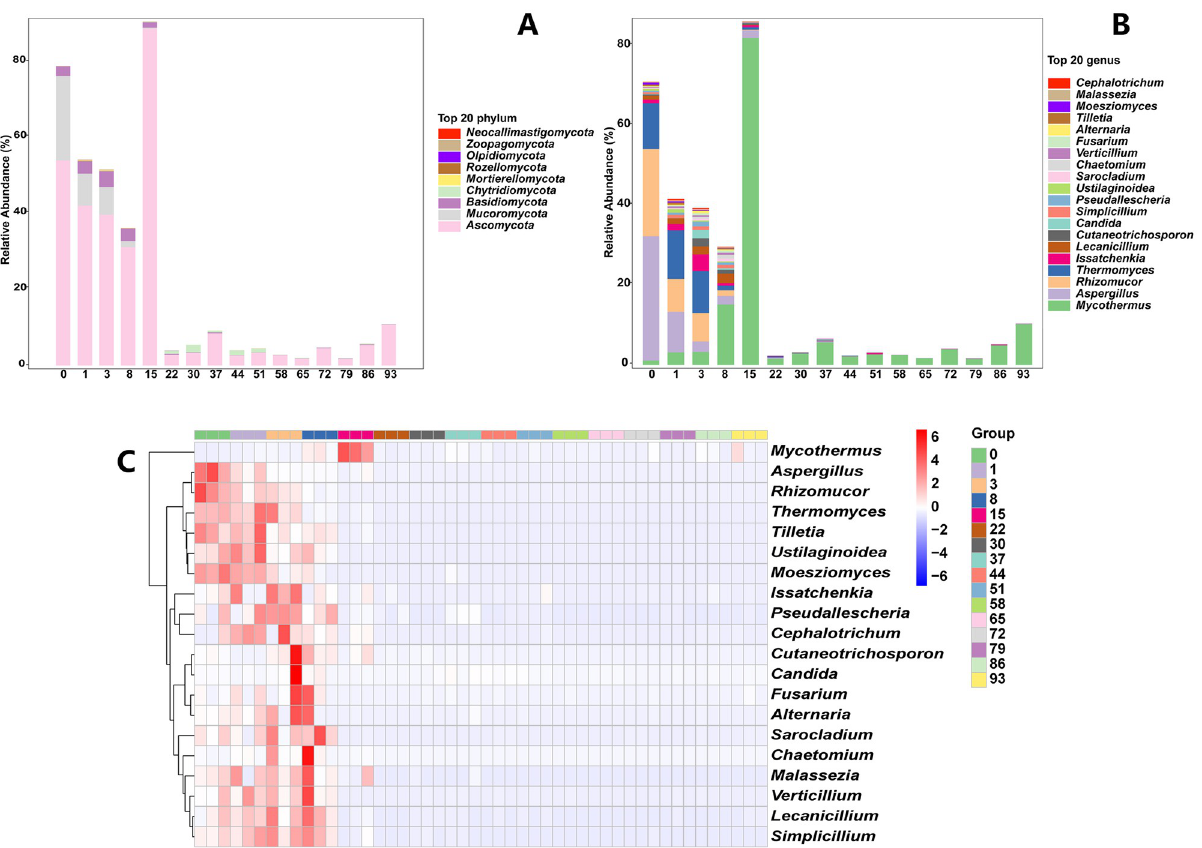
Fig 7. Changes in fungal phylum and genus level and heatmap of top 20 genus in sample in ectopic fermentation of dairy